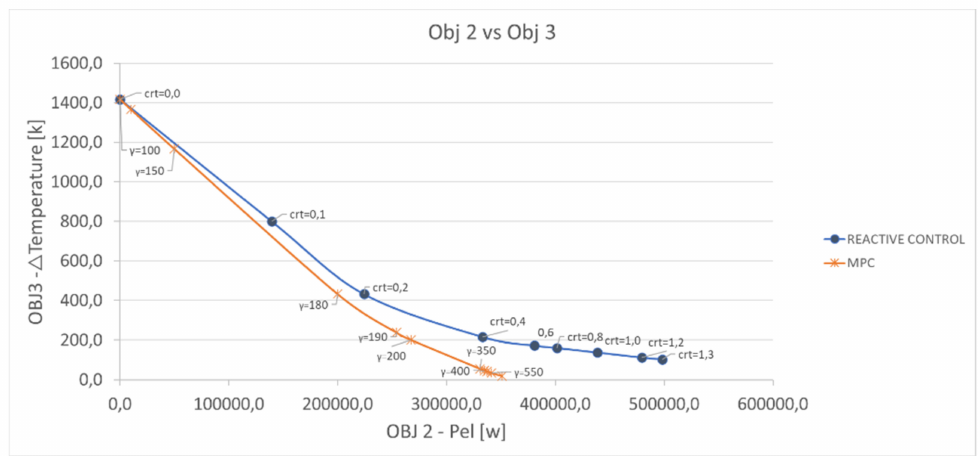
Figure 13. MPC vs. the reactive method performance